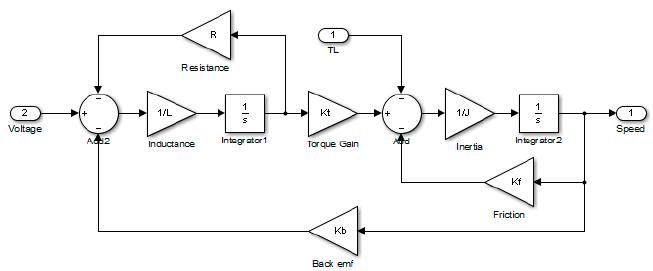
Figure 12. The block diagram of the DC motor.